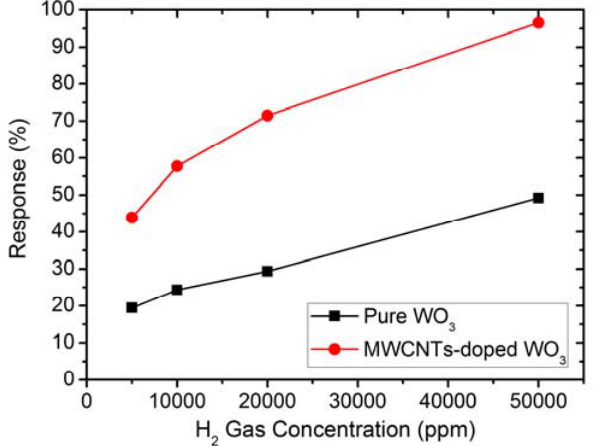
Figure 6. Sensing response of the undoped WO high H concentrations (5,000–50,000 ppm) at the operating temperature of 250 2